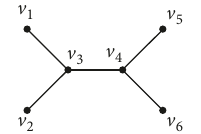
Figure 1: A tree without solution to the SACP for 𝑚 ≥ 3